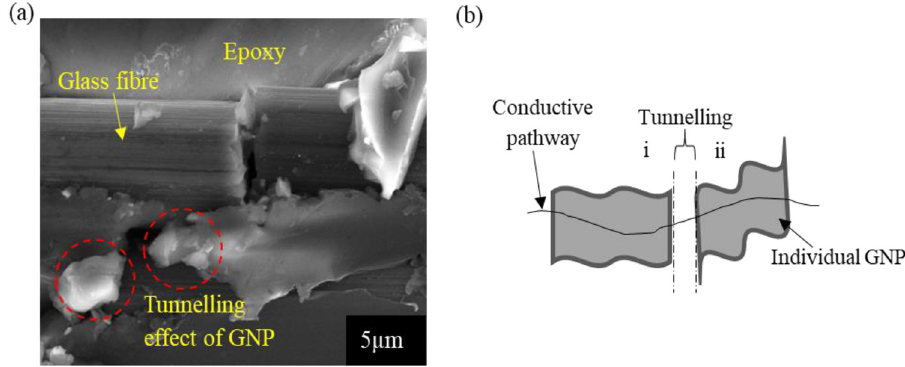
Figure 6: Tunnelling e ff ect: ( a ) FESEM image of possible tunnelling e ff ect of GNP and ( b ) modelling distribution of GNP in epoxy.